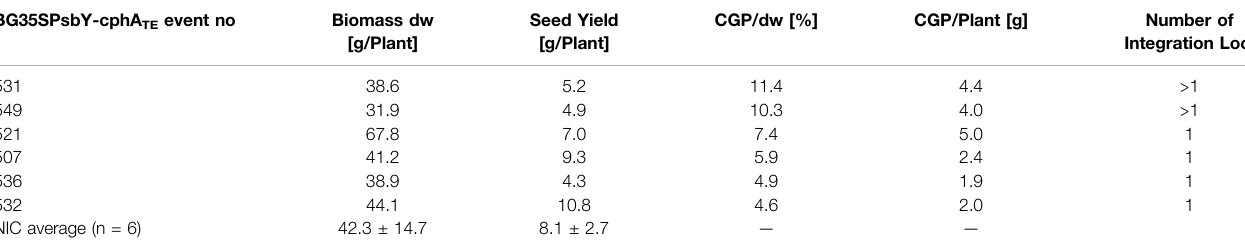
TABLE 1 | T0 events selected for the fi eld trial.